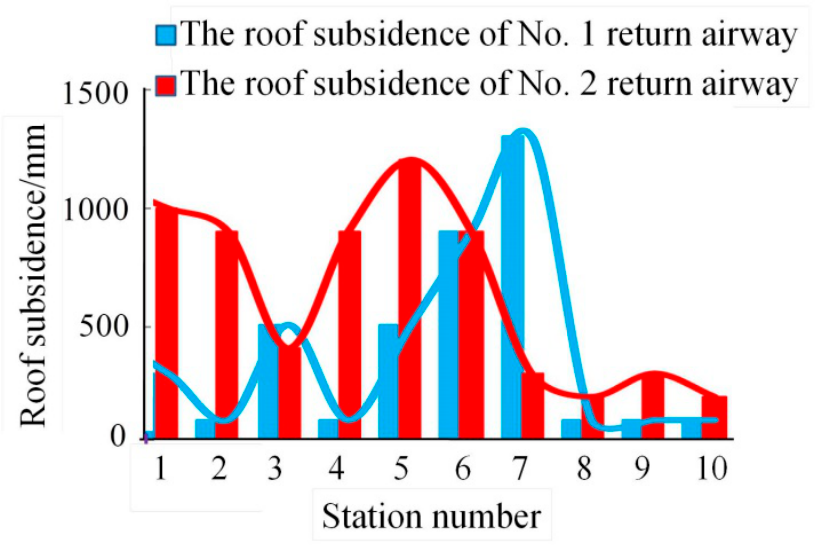
Figure 16. Monitoring statistics of roof subsidence in the test roadway.